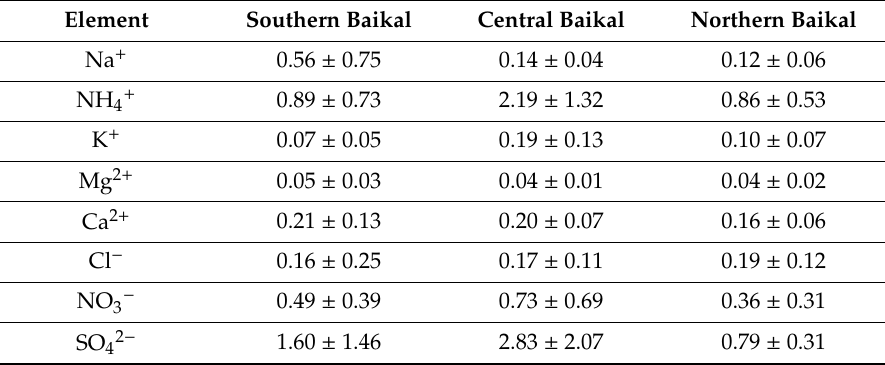
Table 4. Average values and standard deviations of the ionic concentrations in the composition of atmospheric aerosol in the near-water atmosphere of Lake Baikal (from 24 July to 4 August 2019). Element Southern